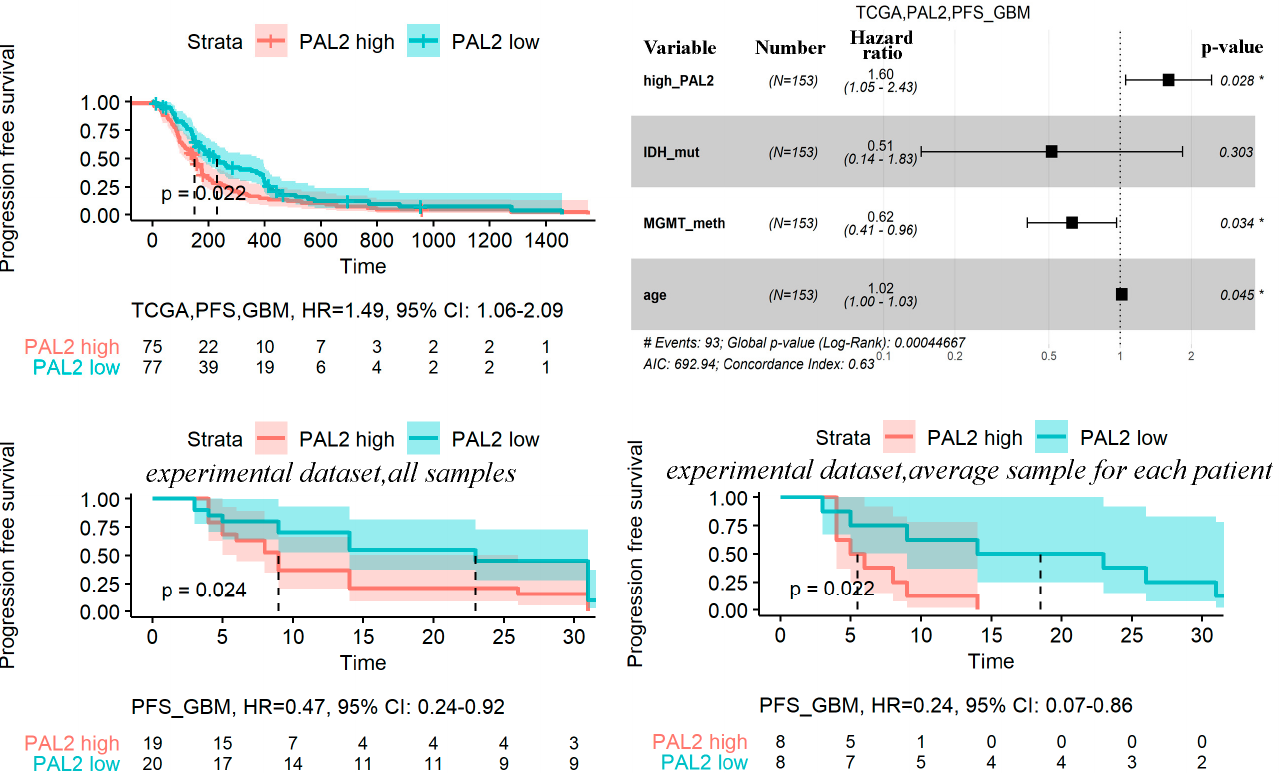
Figure 7. Kaplan-Meyer, univariate and multivariate Cox analyses of progression-free survival in GBM for TCGA. Kaplan- Meyer and univariate Cox analyses of progression-free survival in GBM for experimental dataset (for all samples and for averaged (by patient) samples). The samples were grouped by PAL2 level relative to the median value of PAL2 (“high” PAL2: PAL2 > median (PAL2); “low” PAL2: PAL2 < median (PAL2)). Time is given in days for the TCGA dataset, and in months for the experimental dataset. * stands for p < 0.05.